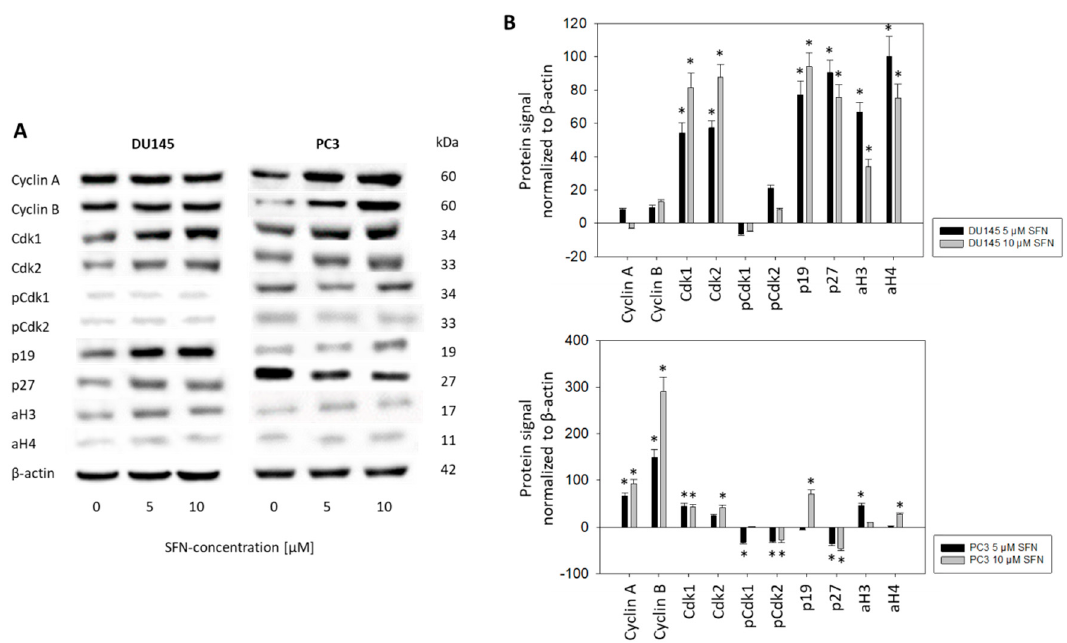
Figure 4. ( A ) Protein profile of cell-cycle-regulating proteins and histone H3 and H4 acetylation after exposure to 5 or 10 µ M sulforaphane (SFN). Controls were untreated (0 µ M SFN). One representative of three separate experiments is shown. Each protein analysis was accompanied by a β -actin loading control. One representative internal control is shown. ( B ) The ratio of protein intensity / β -actin intensity was calculated and expressed as a percentage of the controls, set to 100%. * Indicates significant difference to controls, p ≤ 0.05. n = 3.